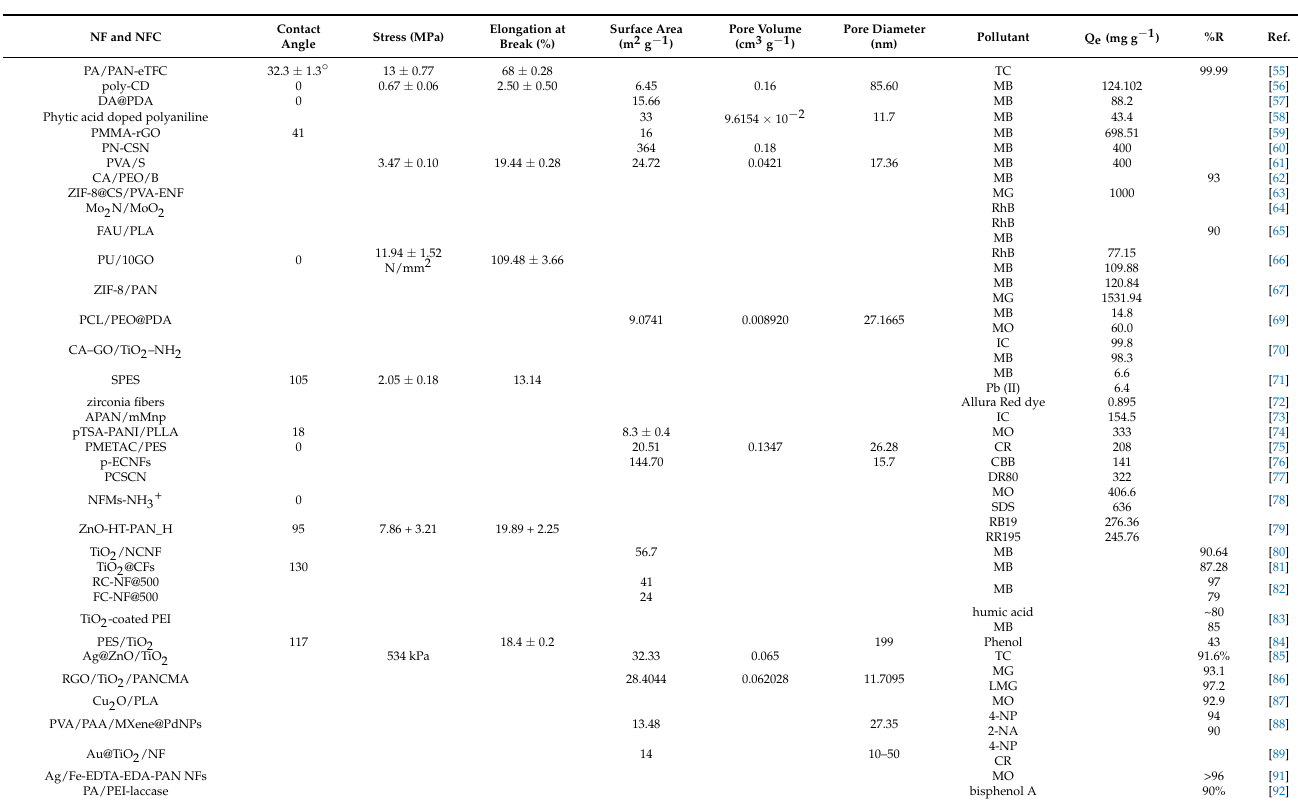
Table 1. Summary of optimum conditions for nanofibers used in the removal of organic and inorganic